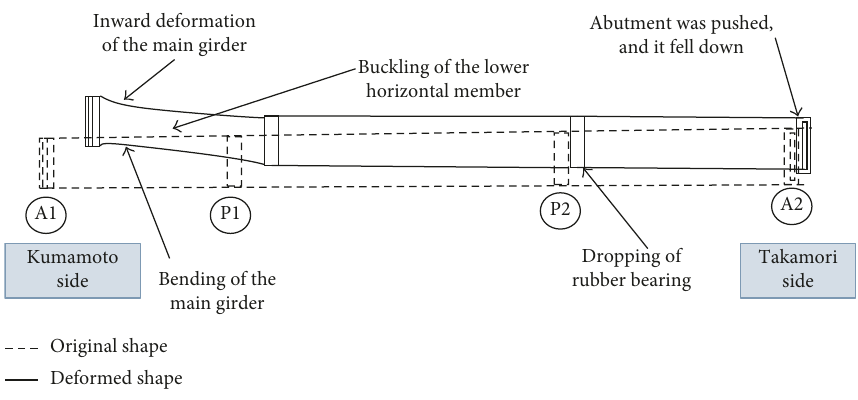
Figure 22: Deformation mechanism of the whole bridge.